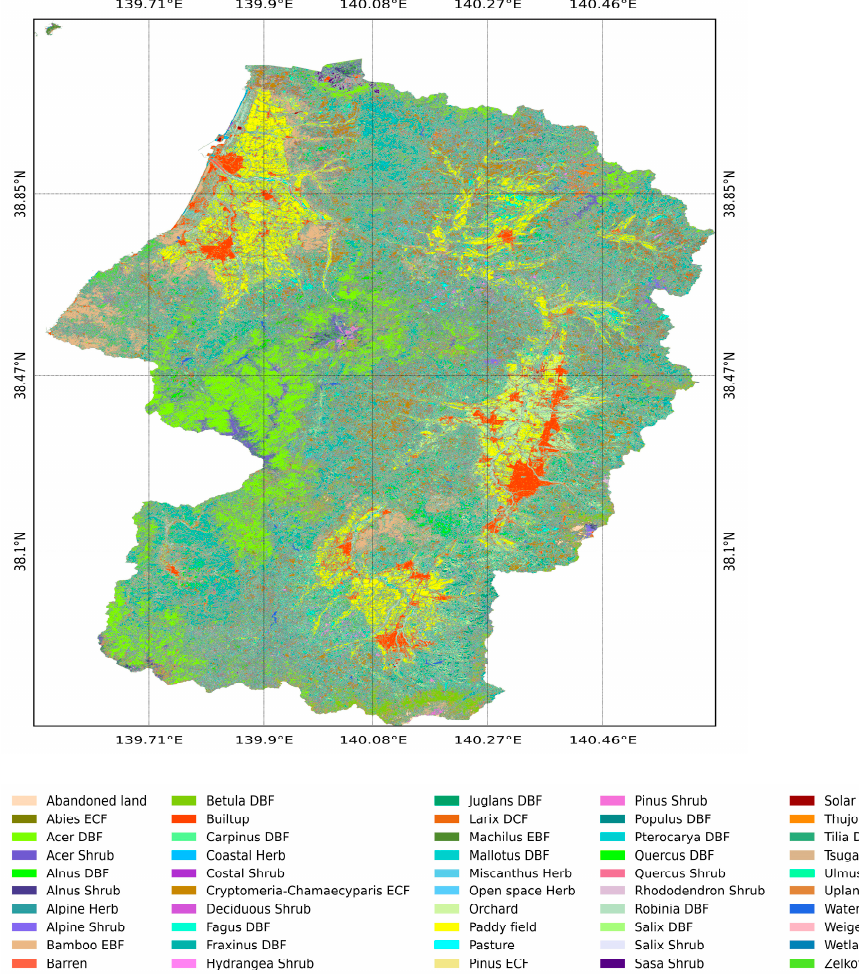
Figure 2. Plant ecological communities map of the Yamagata prefecture with 50 classes including land cover and agricultural types, produced in the research.